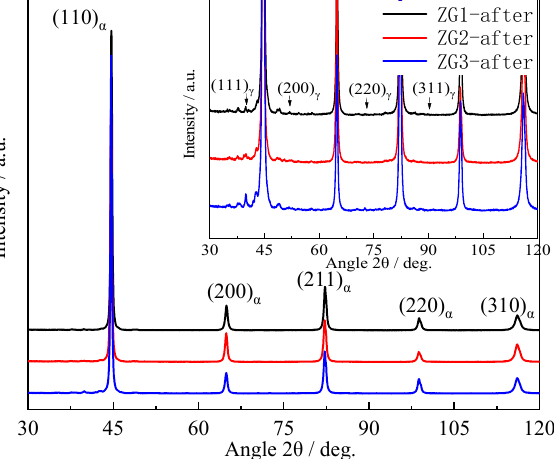
Figure 10. X-ray diffraction profiles of specimens after thermal fatigue test.